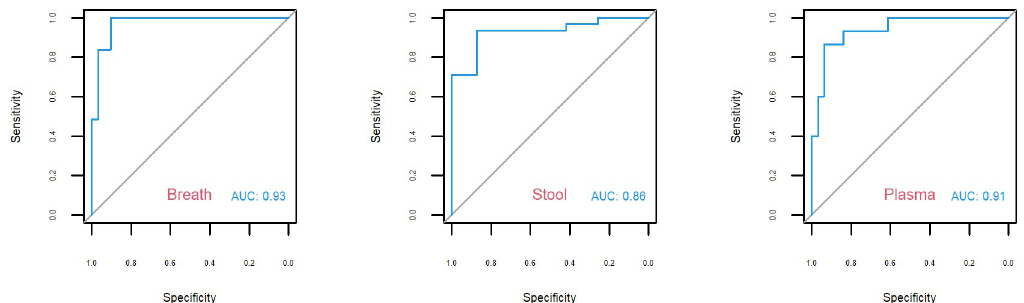
Fig 3. Receiver operating characteristic (ROC) curves with area under the curve for breath, stool and plasma samples